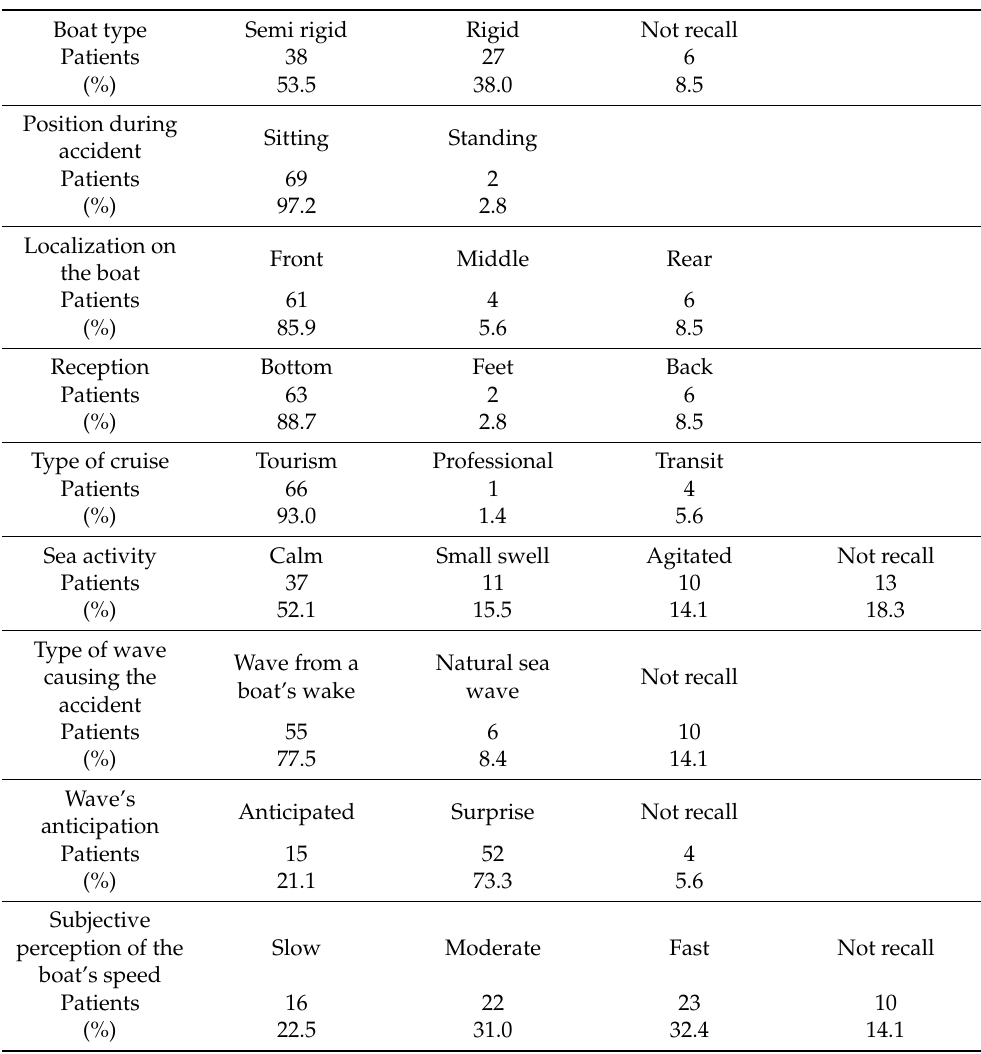
Table 5. Contextual characteristics of the